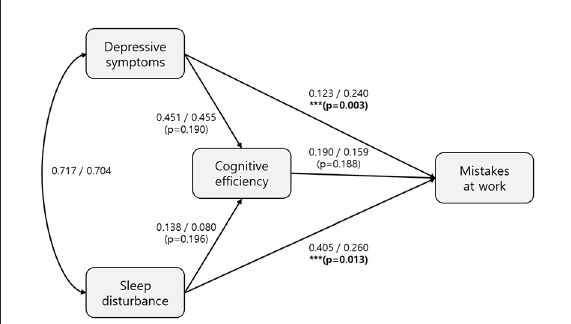
FIGURE2 Structural equation model of the effects of depressive symptoms, sleep disturbances and cognitive efficiency on mistakes at work by shift and non-shift workers. The structural equation model includes sleep disturbances, depressive symptoms, cognitive efficiency, and mistakes at work by shift and non-shift workers. The path coefficients for the shift and non-shift workers are on the left and right side of the slashes, respectively. The models for shift and non-shift workers both fit the data well: χ 2 (df = 114, n = 4,561) = 2,812.582, p < 0.001, CFI = 0.933, TLI = 0.910, RMSEA = 0.072, 95% CI RMSEA [0.070, 0.074] for shift workers and χ 2 (df = 114, n = 2,093) = 1,153.725, p < 0.001, CFI = 0.937, TLI = 0.916, RMSEA = 0.066, 95% CI RMSEA (0.063, 0.070) for non-shift workers. In the shift workers, sleep disturbances were associated with cognitive efficiency (path coefficient = 0.138; p < 0.001) and mistakes at work (path coefficient = 0.405; p < 0.001), while depressive symptoms were not significantly associated with mistakes at work (path coefficient = 0.123; p = 0.193). In the non-shift workers, sleep disturbances were associated with cognitive efficiency (path coefficient = 0.080; p = 0.035) and mistakes at work (path coefficient = 0.260; p < 0.001), while depressive symptoms were associated with mistakes at work (path coefficient = 0.240; p < 0.001). The path coefficient between cognitive efficiency and mistakes at work was statistically significant ( p < 0.001) in both shift and non-shift workers. The comparison of path coefficients between shift and non-shift workers were tested using multi-group structural equation model. The p -values of path coefficient comparisons were presented in (). ***Indicates a statistically significant difference between shift and non-shift